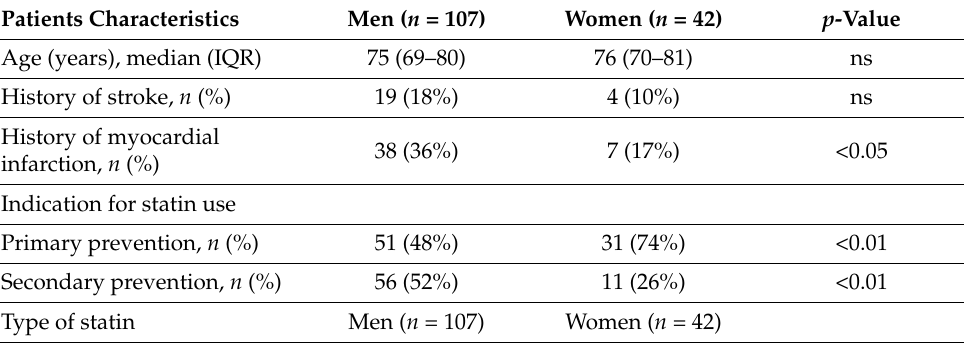
Table 1. Demographic data of the 149 statin users in the study cohort. p -Value shows statistical difference between men and women. Statistical analysis was performed with Fischers exact test for binary outcome and Mann–Whitney-U test for continuous data. p < 0.05 is considered as statistically significant. IQR = interquartile range, ns = not